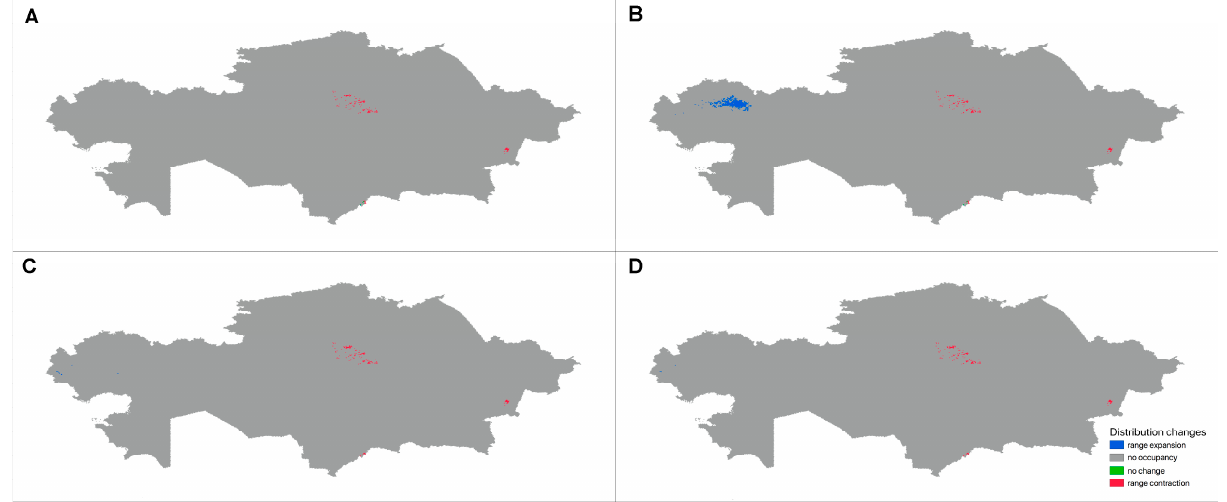
Figure 11. Changes in the distribution of suitable habitats in Kazakhstan for Dactylorhiza incarnata (L.) Soó. and four climate change scenarios—spp126 ( A ), spp245 ( B ), spp370 ( C ), and spp585 ( D ).